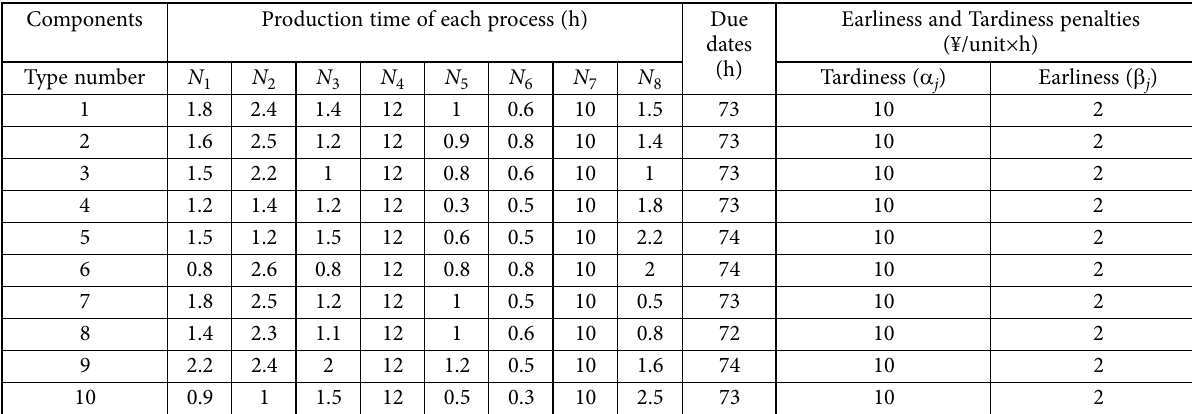
Table 1. Input data of the production scheduling